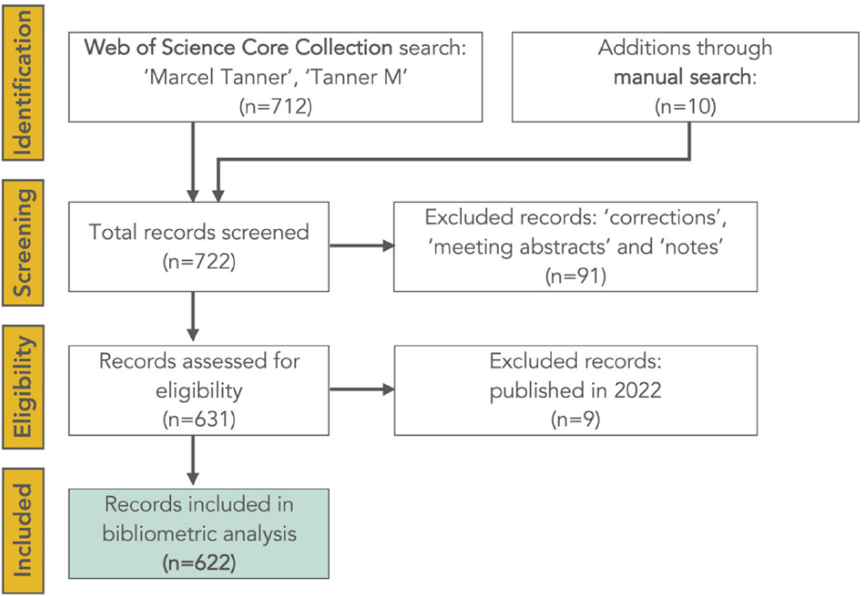
Figure 1. Flow chart of the steps taken to identify Marcel Tanner’s peer-reviewed scholarly contribu- tions between 1978 and 2021 that were subjected to further analyses (source: Web of Science Core Collection, search performed on 3 August 2022).